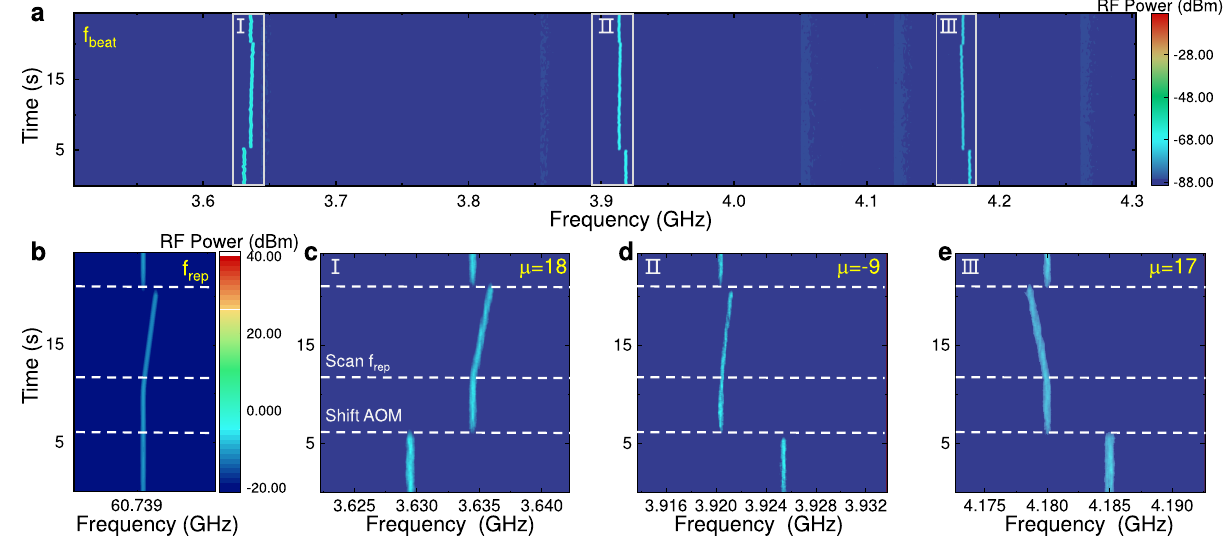
Fig. 3 | Demonstration of the multi-wavelength measurements. a The real-time evolution ofthe beatnote between three probe lasersand the adjacent comb lines within 26s. In this process, the repetition rate is scanned by controlling the